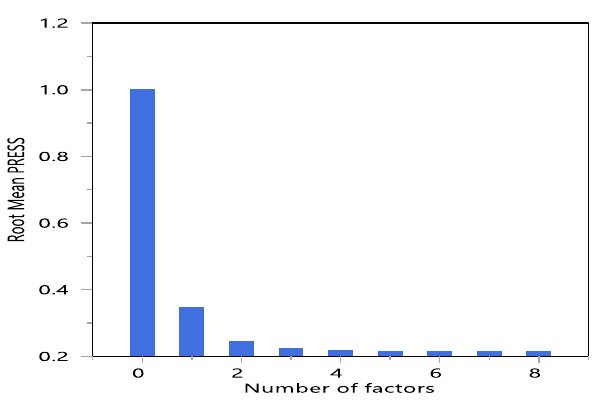
Fig. 24 Number of latent factors versus root mean PRESS for ROP model